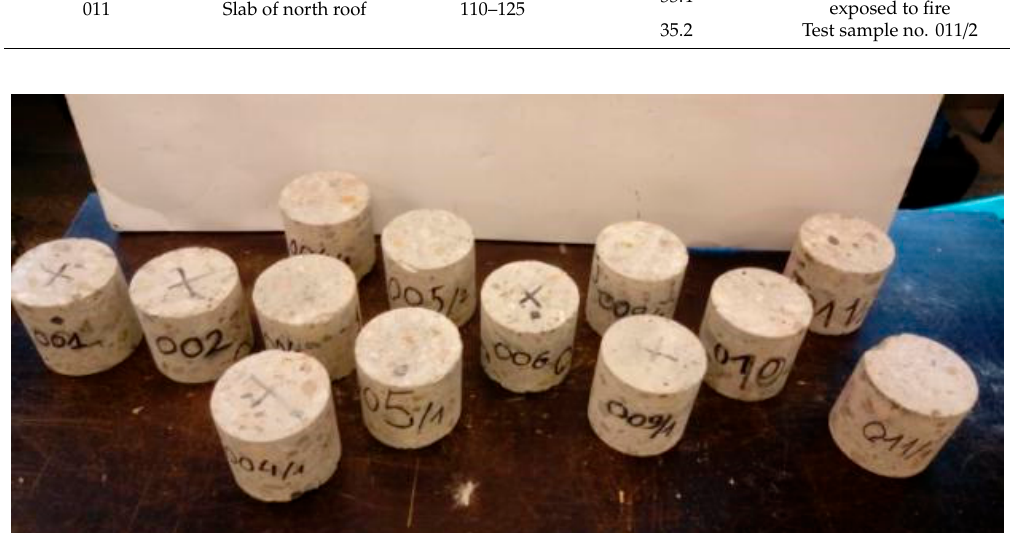
Figure 7. Sample no. 002 during the strength test. 3.2. UPV Model Calibration To determine the strength of concrete in the core samples, i.e., varying strength over the slab depth, the relationship f c = f ( C L ) between the tested ultrasonic wave velocity C L and the compressive strength of concrete f c was established on the samples that were subsequently destructed. That relationship is presented in Figure 8. Based on the regression analysis exponential function was found to fit the best to experimental results.